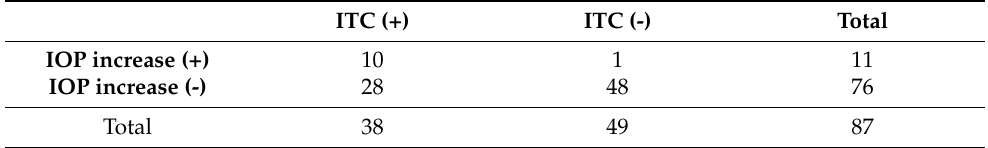
Table 2. Association between the presence of ITC and IOP increase after